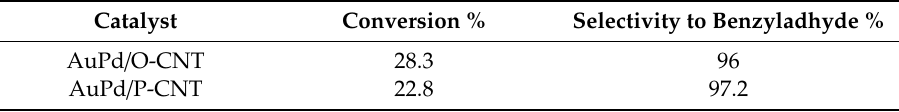
Table 2. Oxidation of benzyl alcohol using Au-Pd / O-CNT and Au-Pd / P-CNT. Catalyst Conversion %